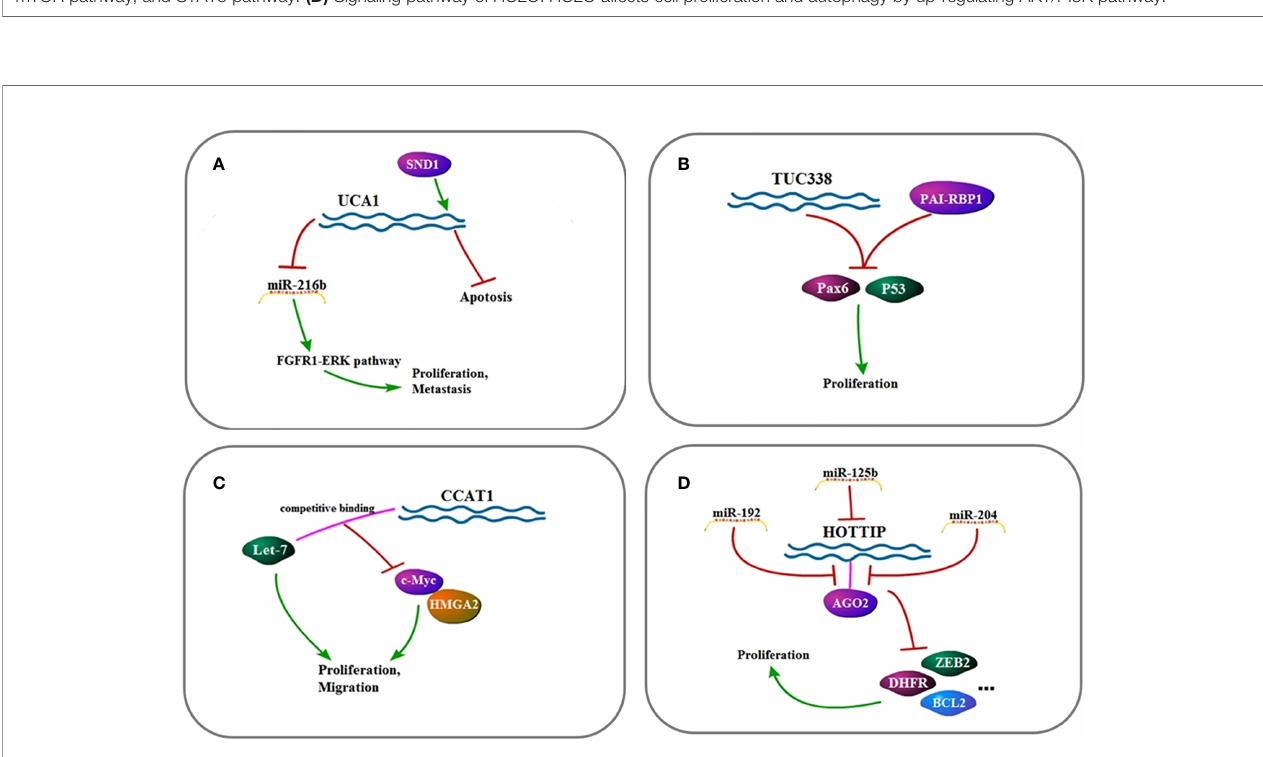
FIGURE 3 | (A) Signaling pathway of UCA1 : UCA1 affects cell metastasis, proliferation, and apoptosis by up-regulating FGFR1 – ERK pathway. (B) Signaling pathway of TUC338 : TUC338 affects cell proliferation by down-regulating Pax6 and P53. (C) Signaling pathway of CCAT1 : CCAT1 affects cell proliferation and migration by regulating let-7 , c-Myc, and HMGA2. (D) Signaling pathway of HOTTIP : HOTTIP affects cell proliferation by down-regulating